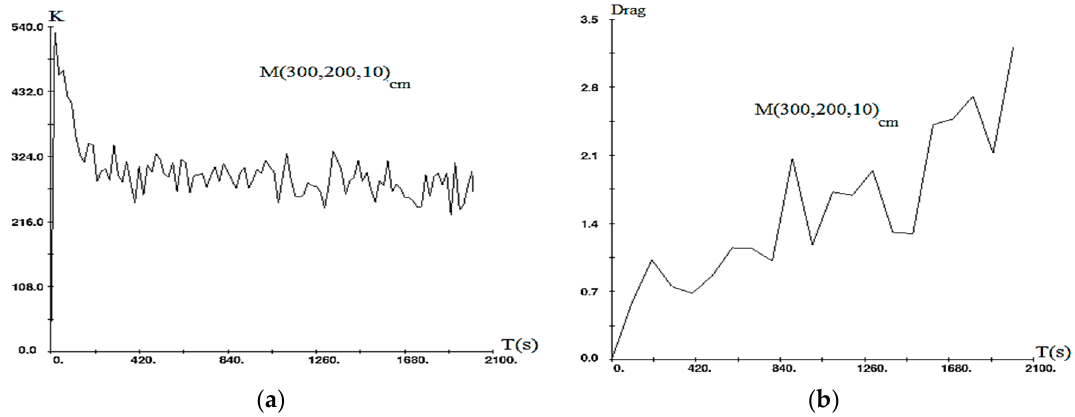
Figure 9. Variations in point M’s ( a ) kinetic energy and ( b ) drag coefficient in the G36316 reservoir. The horizontal axis in Figure 9 indicates time, and the vertical axis is the kinetic energy and drag